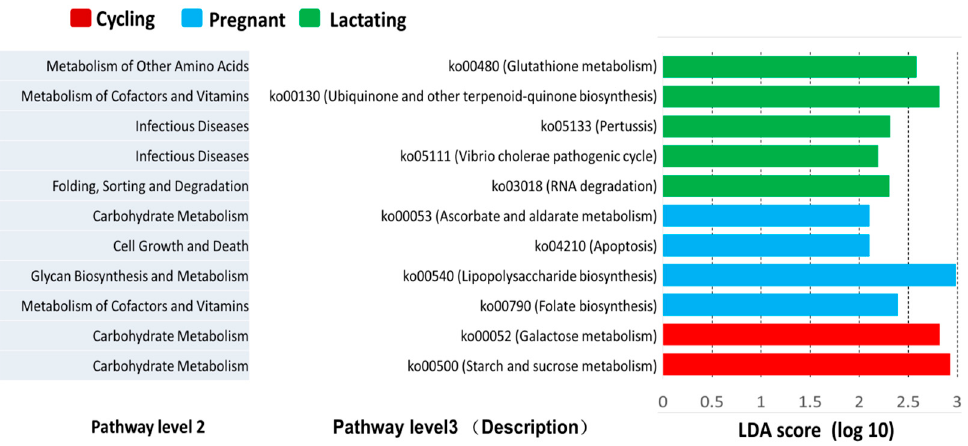
Figure 5. LEfSe analysis on the predicted functional genes of three reproductive states. The predicted functional genes enriched in different reproductive states identified by linear discriminant analysis coupled with effect size (LEfSe) (LDA > 2, p < 0.05).